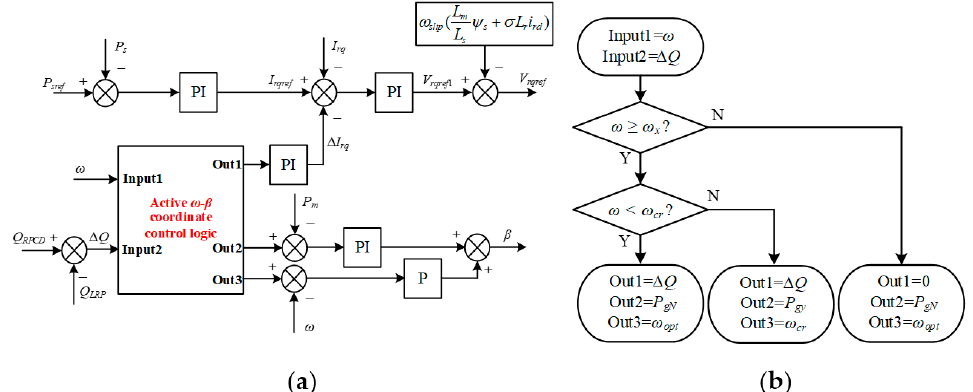
Figure 6. The active ω - β coordinate control strategy and the control logic. ( a ) The active power control and the pitch angle control in the active ω - β coordinate control strategy. ( b ) The active ω - β coordinate control logic.